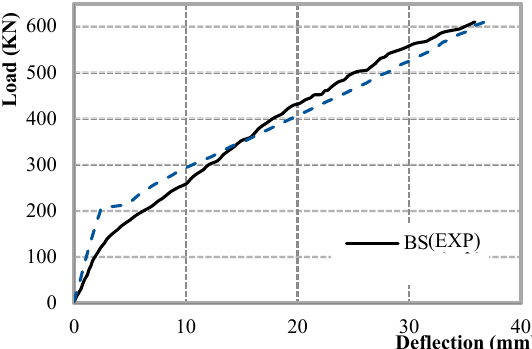
Figure 22. Load-deflection curve of BS2 slab.